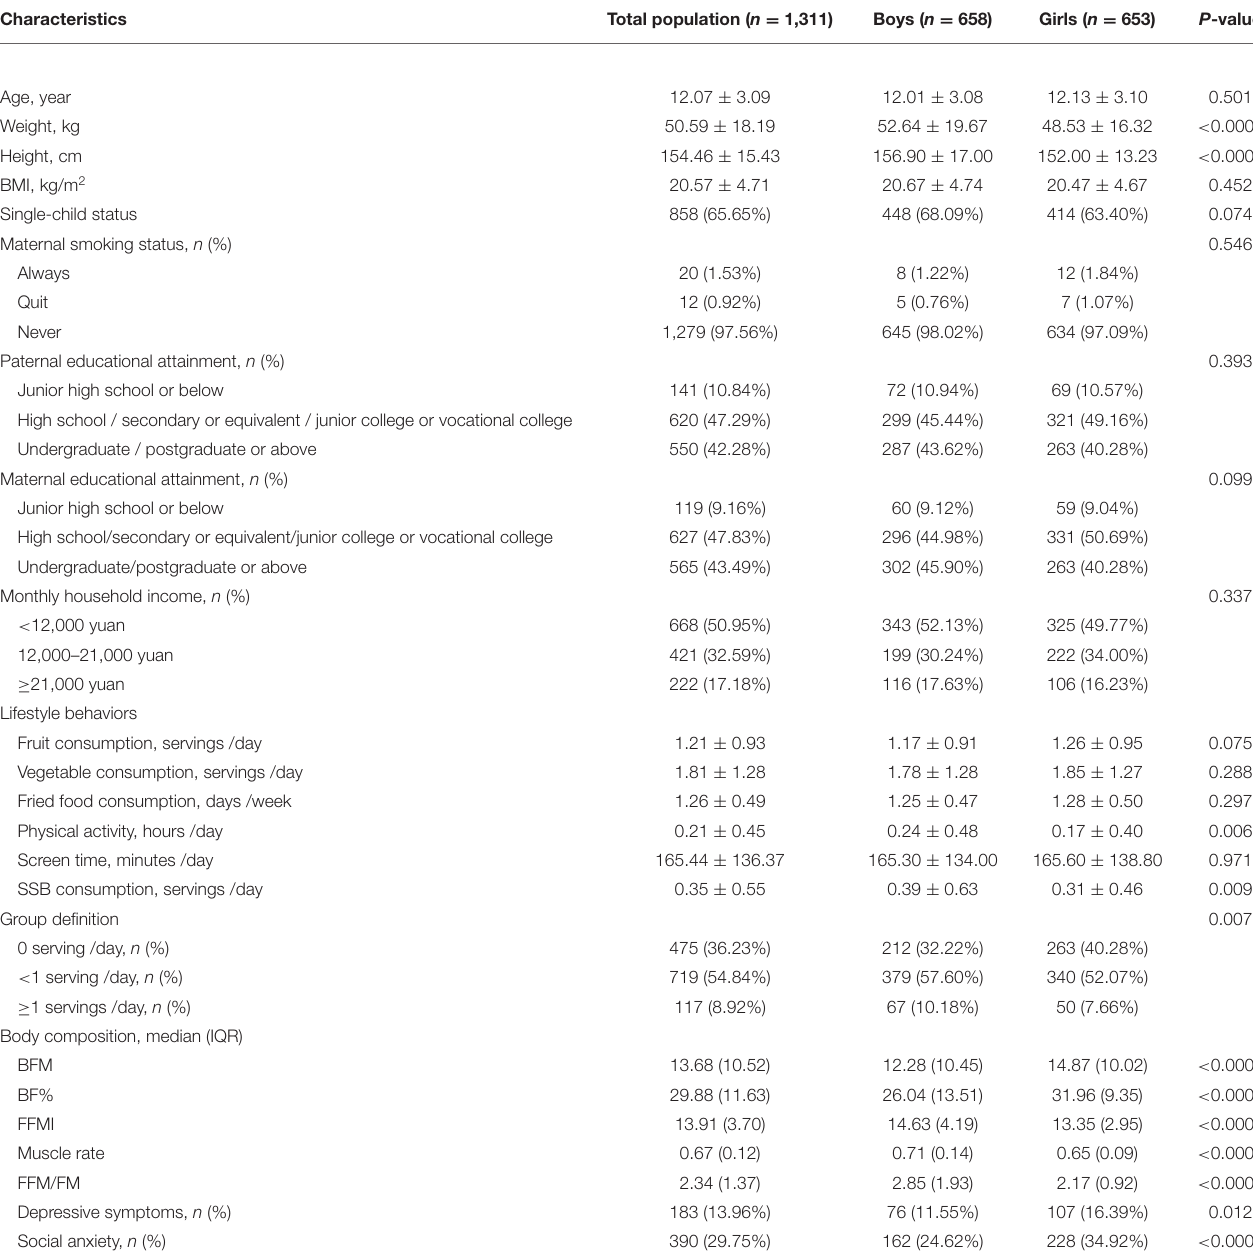
TABLE 1 | Baseline characteristics of included